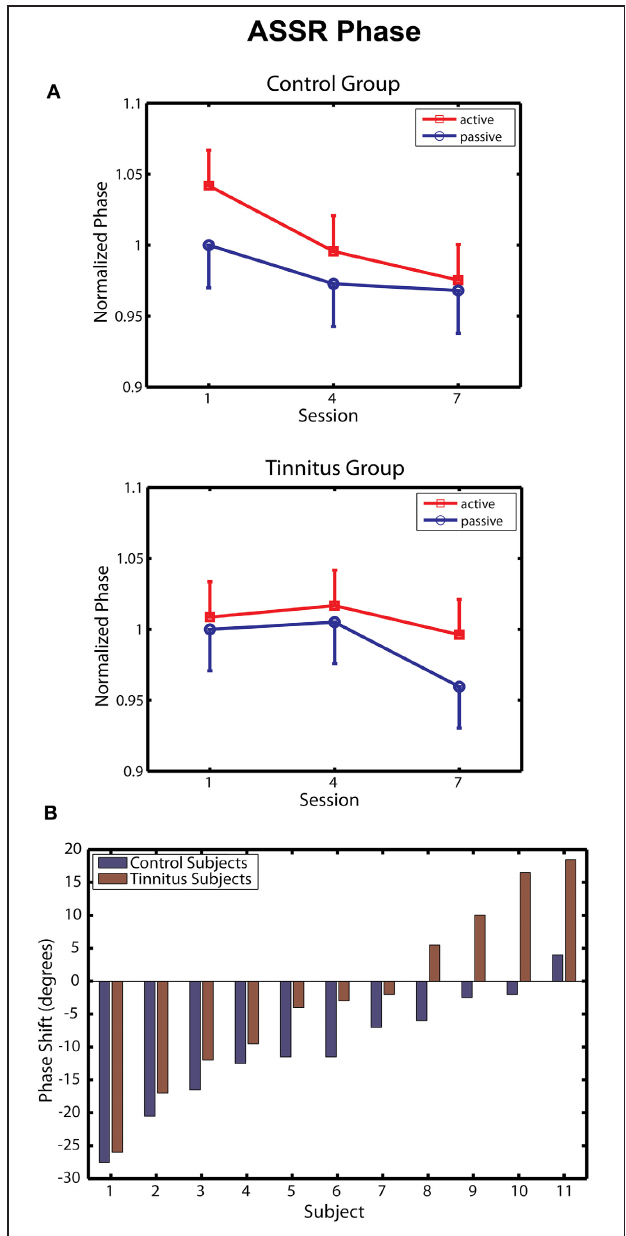
FIGURE 4 | ASSR phase. (A) Change in ASSR phase over training sessions in the Control (top panel) and Tinnitus (bottom panel) groups. Phase is normalized in each group to their baseline on passive blocks of the first session. Negative shifts denote advances of the 40-Hz response waveform toward the zero-crossing of the 40-Hz stimulus waveform. Bars are 1 within-subject standard error. (B) Changes in phase (session 7 – Session 1, active blocks) are shown for each participant in the active and control groups. Phase changes are shown in degrees. Subjects within each group are ordered by the magnitude of the phase